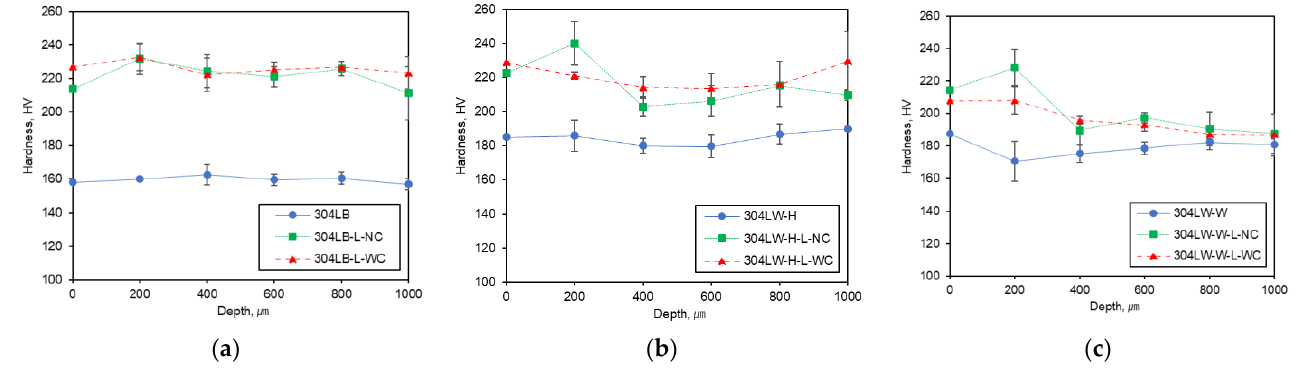
Figure 13. The hardness of the cross-section of 304L stainless steel after LP: ( a ) base metal, ( b ) HAZ, and ( c ) weldment.